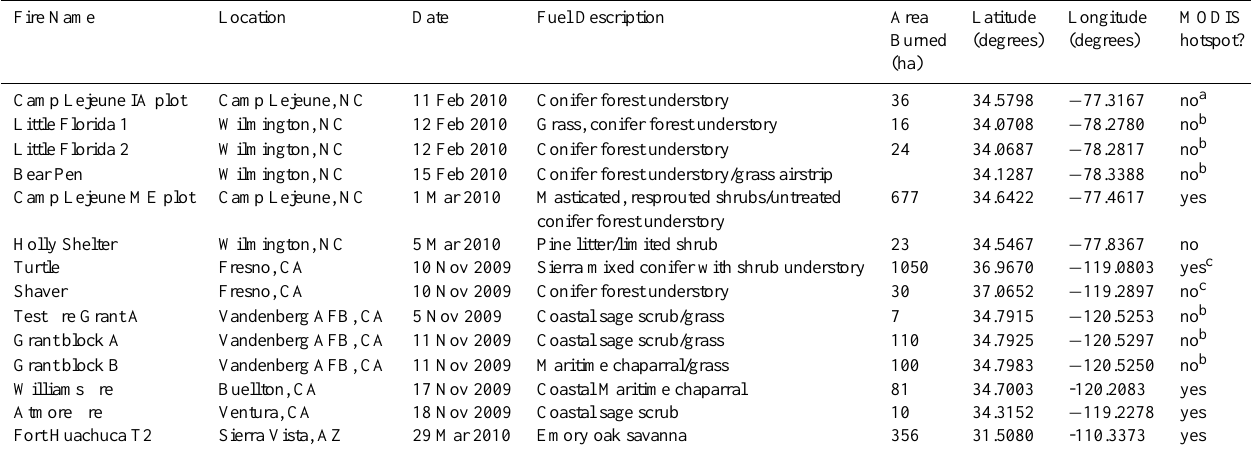
Table 1. Fire name, location, date, fuels, and size for fires sampled in this